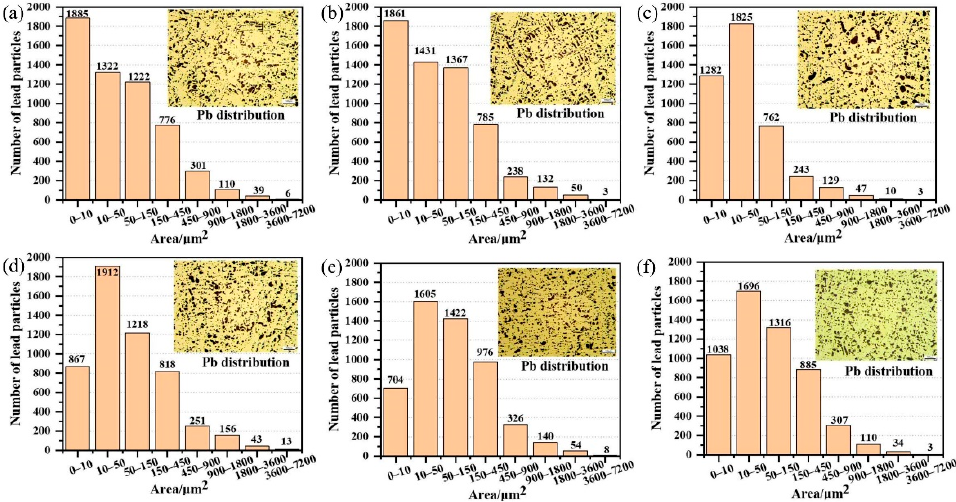
Figure 6. The copper layer Pb statistics. ( a ) 400 °C, ( b ) 500 °C, ( c ) 600 °C, ( d ) 700 °C, ( e ) 800 °C, and ( f ) 900 °C.